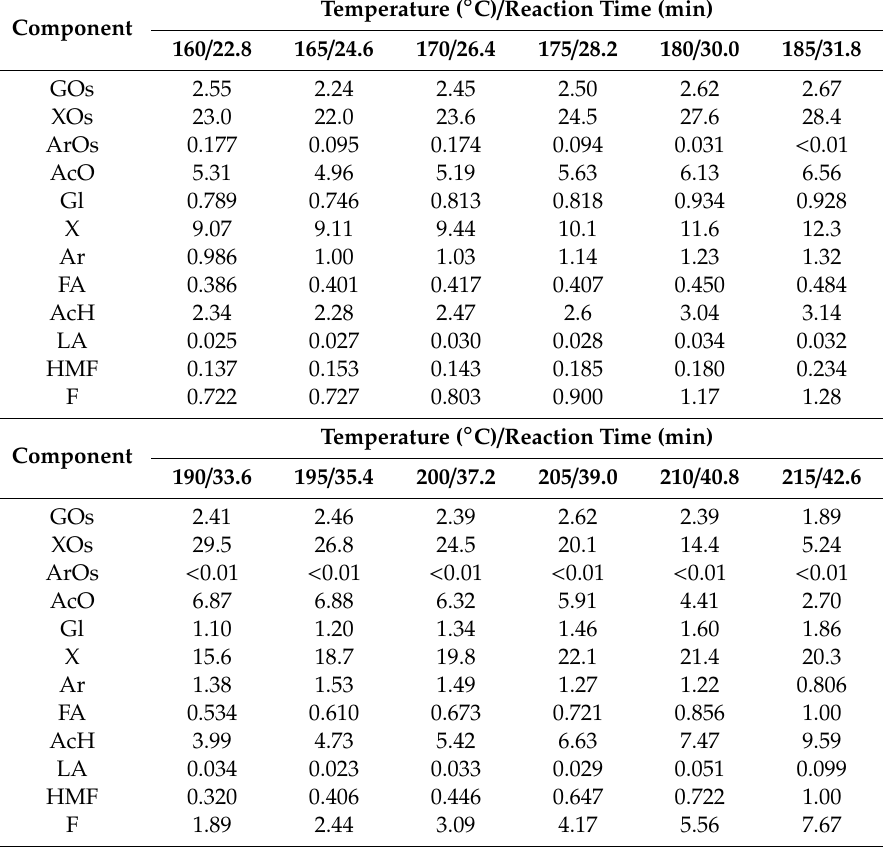
Table 4. Concentrations determined for the target products (in g / L) in the liquid phase from the third reaction